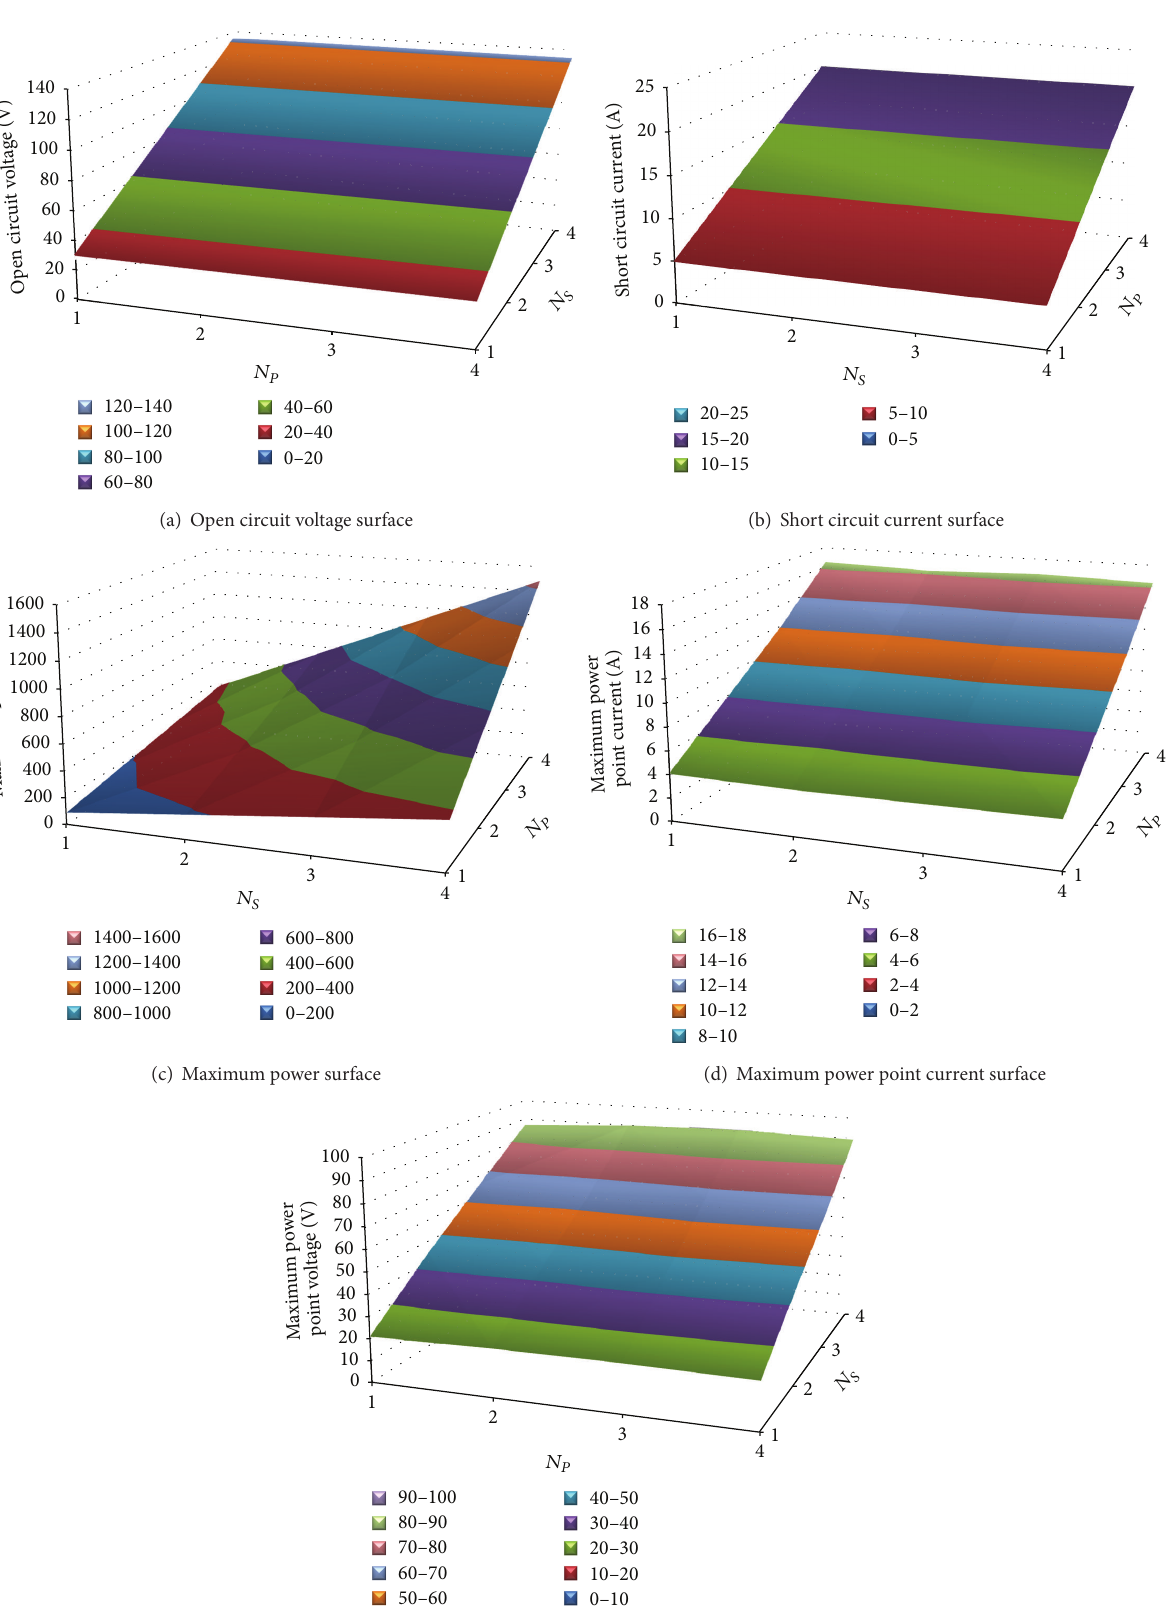
Figure 7: The sizing effects on the array characteristics at reference temperature and solar irradiation levels. (a) Open circuit voltage surface, (b) short circuit current surface, (c) maximum power surface, (d) maximum power point current surface, and (e) maximum power point voltage